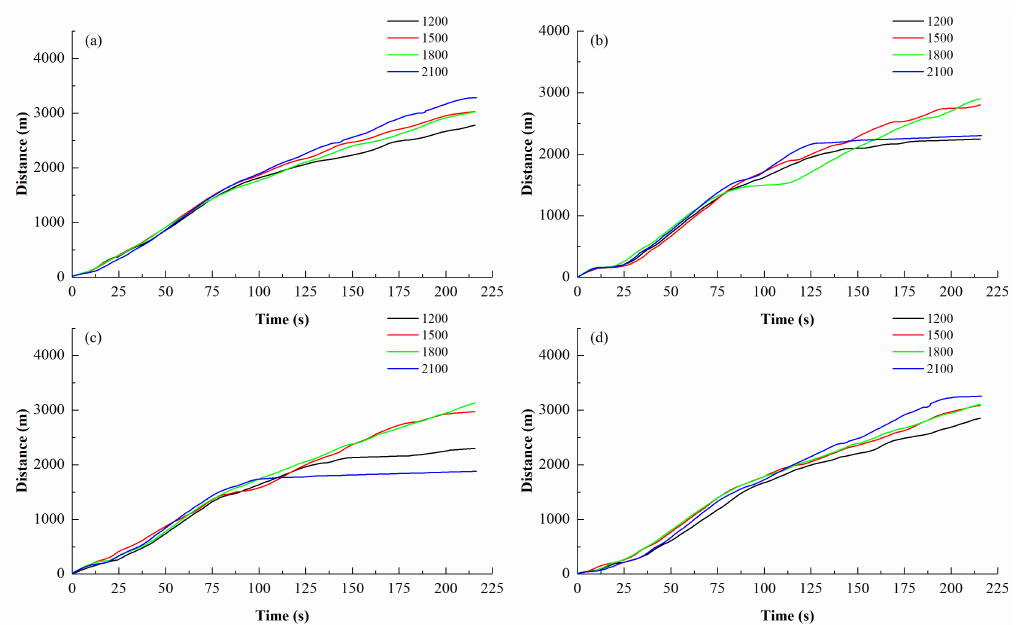
Figure 14. Influence of debris flow density on movement distance of boulders with different shapes: ( a ) spherical, ( b ) cuboid, ( c ) rhombohedron, and ( d )